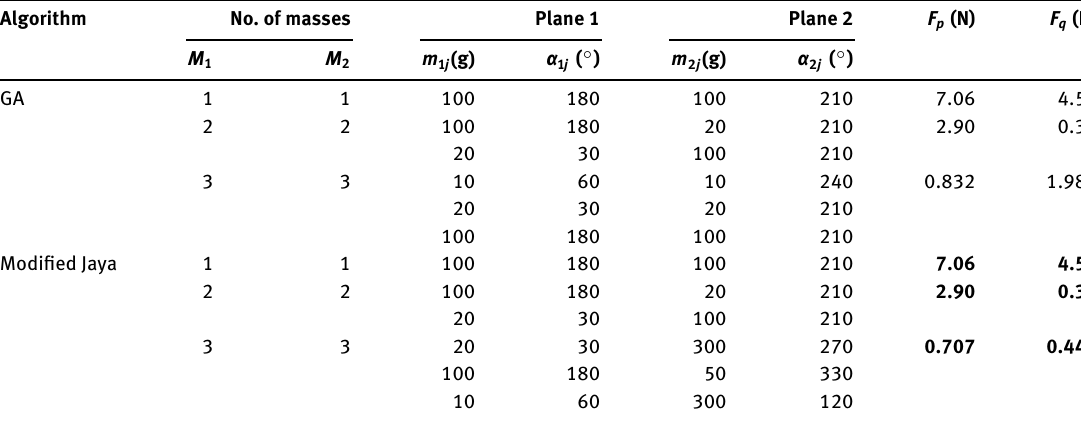
Table 9: Comparison of Optimum Results of Modified Jaya Algorithm to GA [27] for Case